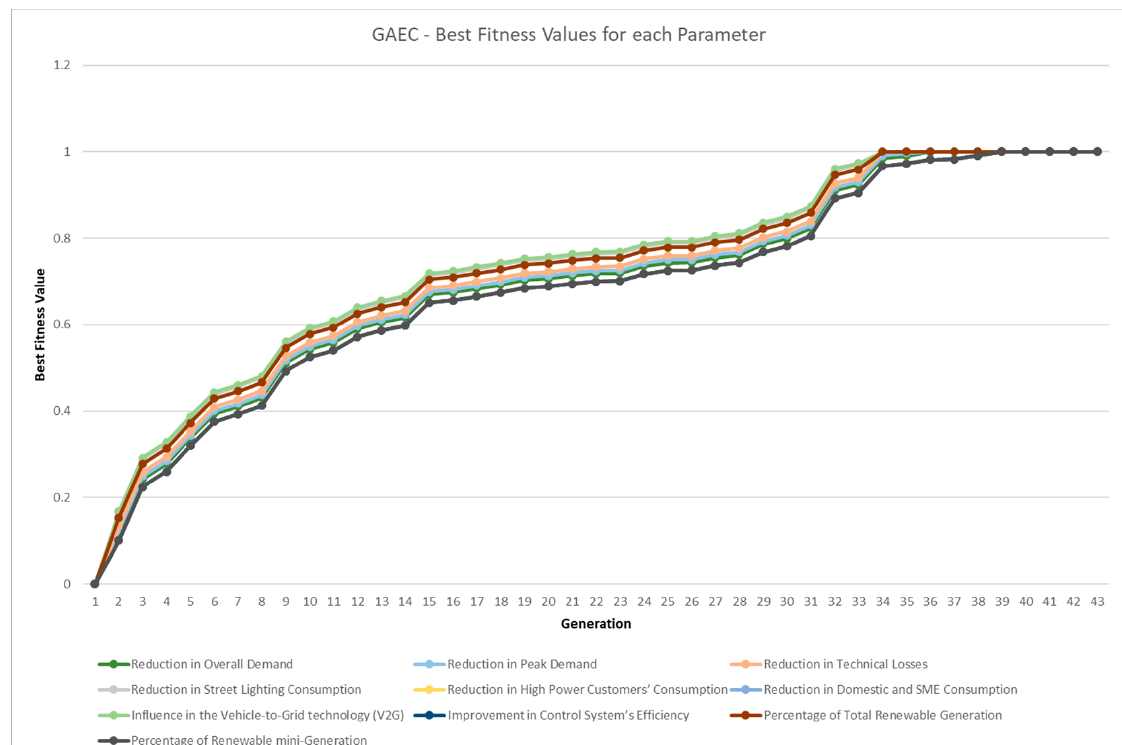
Figure 9. Best fi tness values per generation for 10 parameters in GA. Figure 9. Best fitness values per generation for 10 parameters in GA.